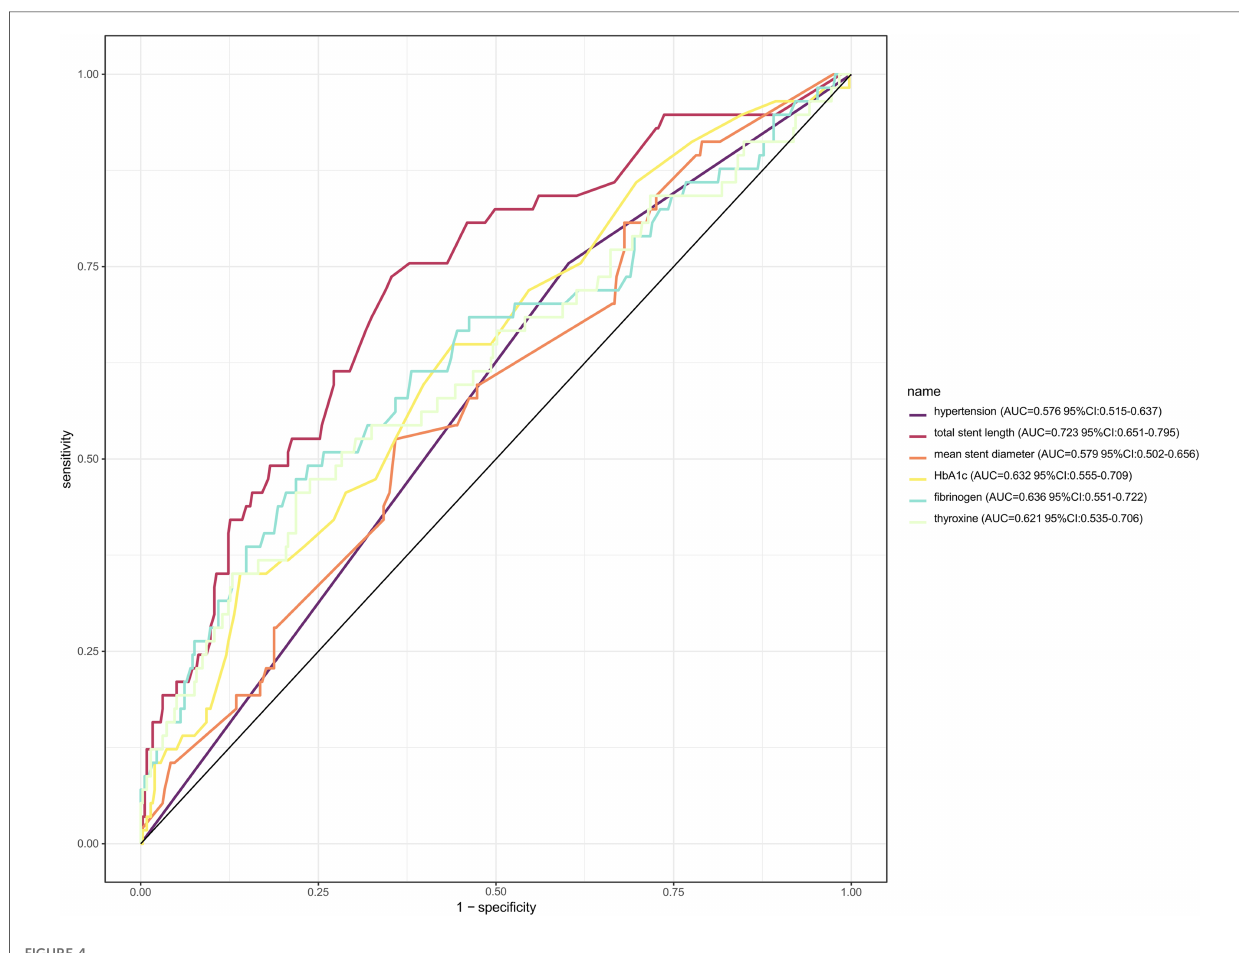
FIGURE 4 ROC curve and the diagnostic performance of individual predictors.